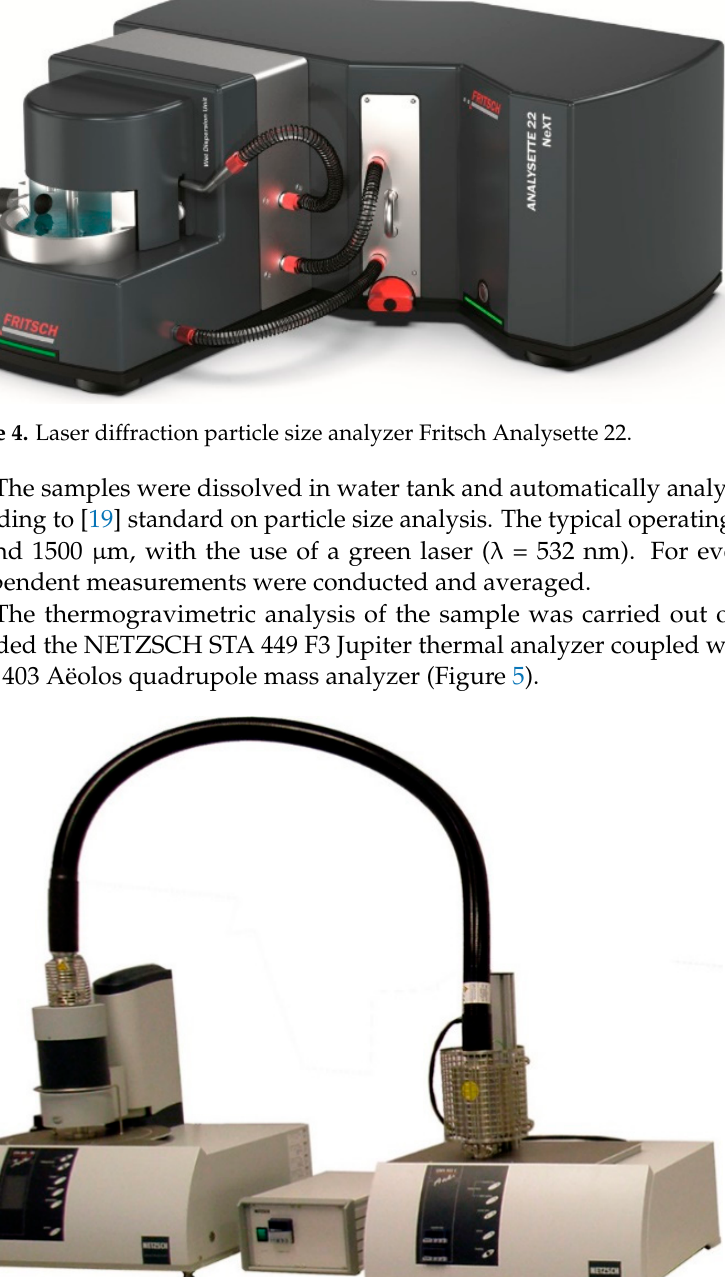
6 of 14 Figure 3. Diagram of the granulate preparation system used in the research: 1—input material feed- ing system; 2—intensive mixer; 3—plate mixer; 4—granules. 3. Methods